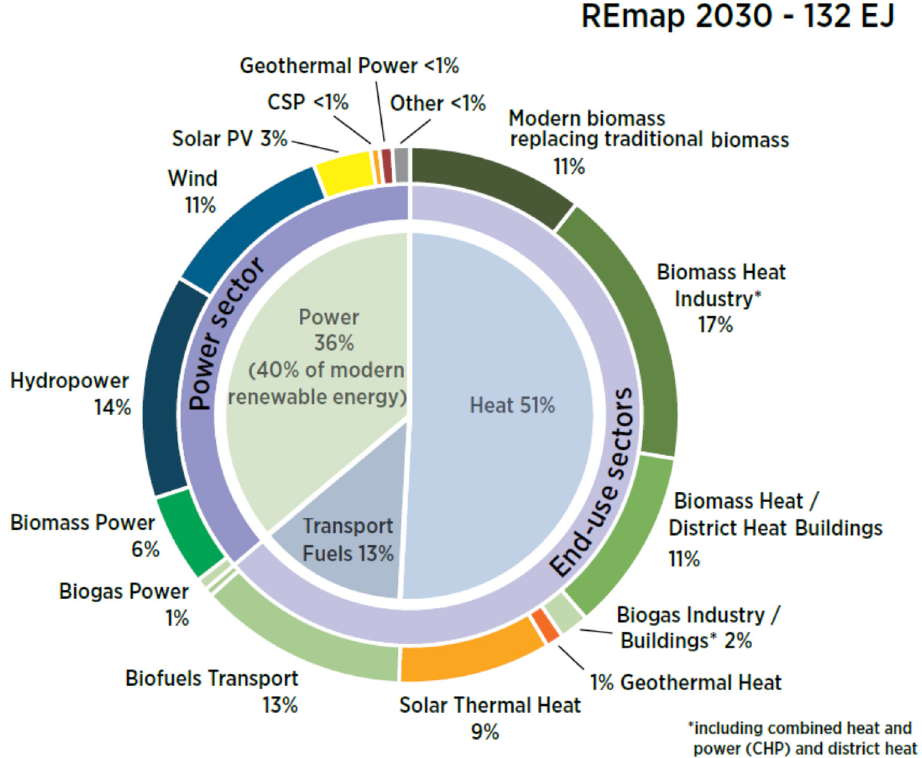
Figure 3. Breakdown of global renewable energy use in 2030 for REmap. Source: